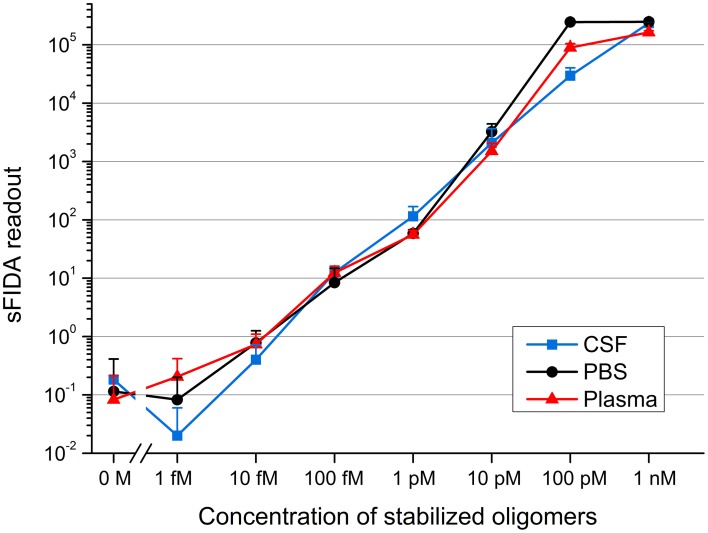
sFIDA readout of stabilized oligomers diluted in CSF, PBS, and a plasma fraction. Shown are mean values and standard deviations from fourfold (samples containing stabilized oligomers) or 21-fold (all blanks) determinations. Cutoffs for channel 635 nm/channel 488 nm: CSF, 3268/2339; PBS, 4082/2773; plasma fraction, 4259/2028.